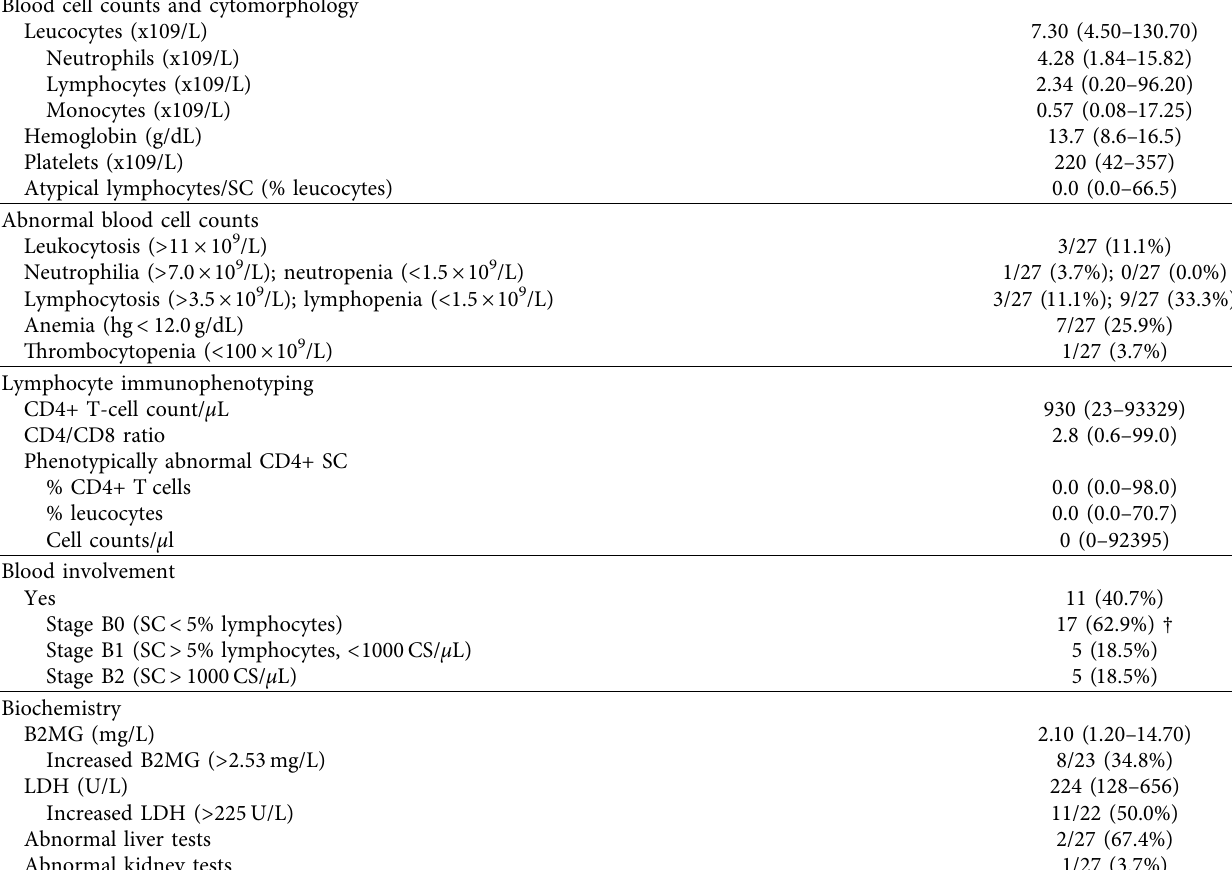
Table 2: Laboratorial features of the CTCL study population, at the time of the